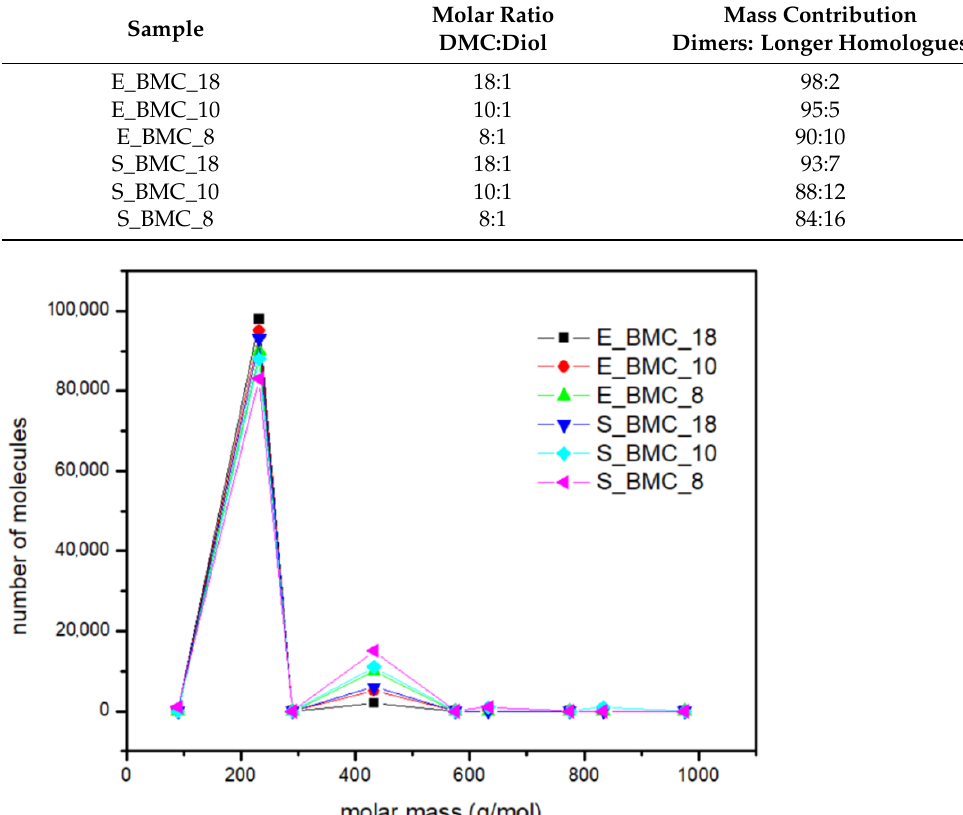
Table 7. Molar ratios of substrates and products in the first stage of the synthesis.